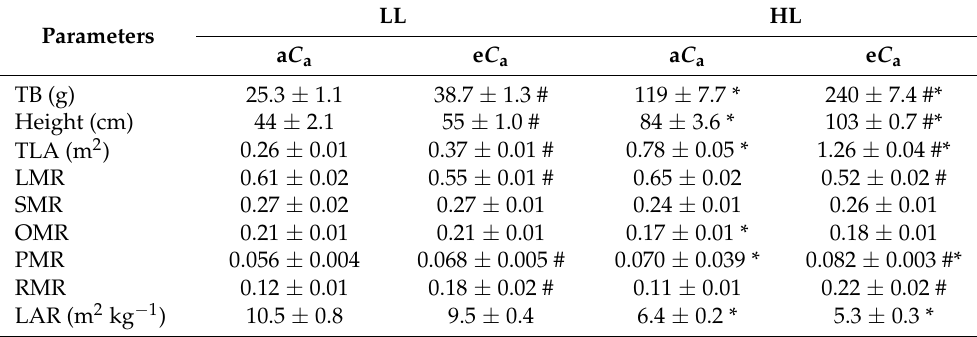
Table 4. The effect of light intensity [low (LL) or high (HL)] and CO 2 supply [ambient (a C a ) or elevated (e C a )] on growth traits of coffee plants: height, total biomass (TB), height, total leaf area (TLA), leaf mass ratio (LMR), stem mass ratio (SMR), orthotropic branch mass ratio (OMR), plagiotropic branch mass ratio (PMR), root mass ratio (RMR), and leaf area ratio (LAR). When shown, asterisk (*) indicates differences between light regimes within the same CO 2 supply, whereas hash (#) indicates differences between CO 2 treatments within the same light regime ( p ≤ 0.05, t test, n = 6 ± SE). LL HL Parameters a C a e C a a C a e C a TB (g) 25.3 ± 1.1 38.7 ± 1.3 # 119 ± 7.7 * 240 ± 7.4 #* Height (cm) 44 ± 2.1 55 ± 1.0 # 84 ± 3.6 * 103 ± 0.7 #* TLA (m 2 ) 0.26 ± 0.01 0.37 ± 0.01 # 0.78 ± 0.05 * 1.26 ± 0.04 #* LMR 0.61 ± 0.02 0.55 ± 0.01 # 0.65 ± 0.02 0.52 ± 0.02 # SMR 0.27 ± 0.02 0.27 ± 0.01 0.24 ± 0.01 0.26 ± 0.01 OMR 0.21 ± 0.01 0.21 ± 0.01 0.17 ± 0.01 * 0.18 ± 0.01 PMR 0.056 ± 0.004 0.068 ± 0.005 # 0.070 ± 0.039 * 0.082 ± 0.003 #* RMR 0.12 ± 0.01 0.18 ± 0.02 # 0.11 ± 0.01 0.22 ± 0.02 # LAR (m 2 kg − 1 ) 10.5 ± 0.8 9.5 ± 0.4 6.4 ± 0.2 * 5.3 ± 0.3